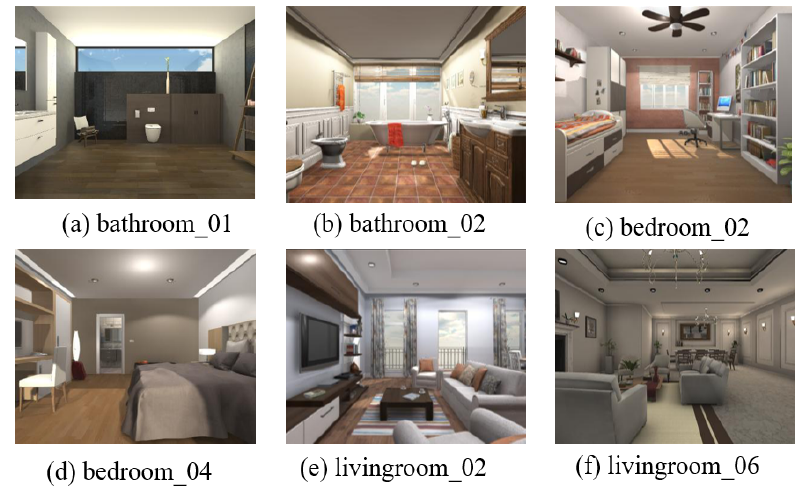
Figure 5. AI2-THOR scene. This is a good representation of the real world in terms of the physics of the